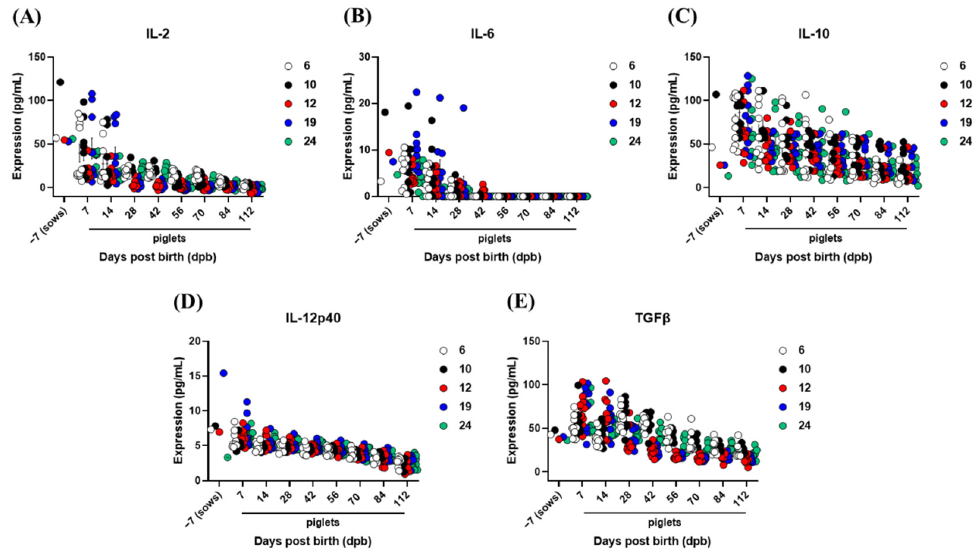
Figure 6. T reg -associated cytokine levels in serum from sows and piglets. Five sows and 10 piglets were screened from each sow. For sows, blood was collected 7 days before farrowing. For the piglets born to sows, blood was collected on 7, 14, 28, 42, 56, 84, and 112 days post birth. The concentration of cytokines, including IL-2, IL-6, IL-10, IL-12p40, and TGF β , was measured using commercially available ELISA kits. Data are presented as the mean ± SEM of triplicate measurements (n = 5 for sows or 10 piglets/sow). ( A – E ) represent: ( A ) IL-2 concentration; ( B ) IL-6 concentration; ( C ) IL-10 concentration; ( D ) IL-12p40 concentration; ( E ) TGF β